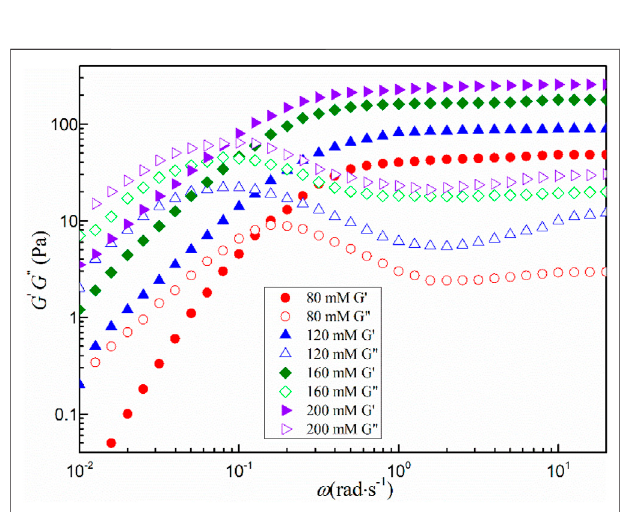
FIGURE 5 | Dynamic shear rheological behavior of the mixed system.